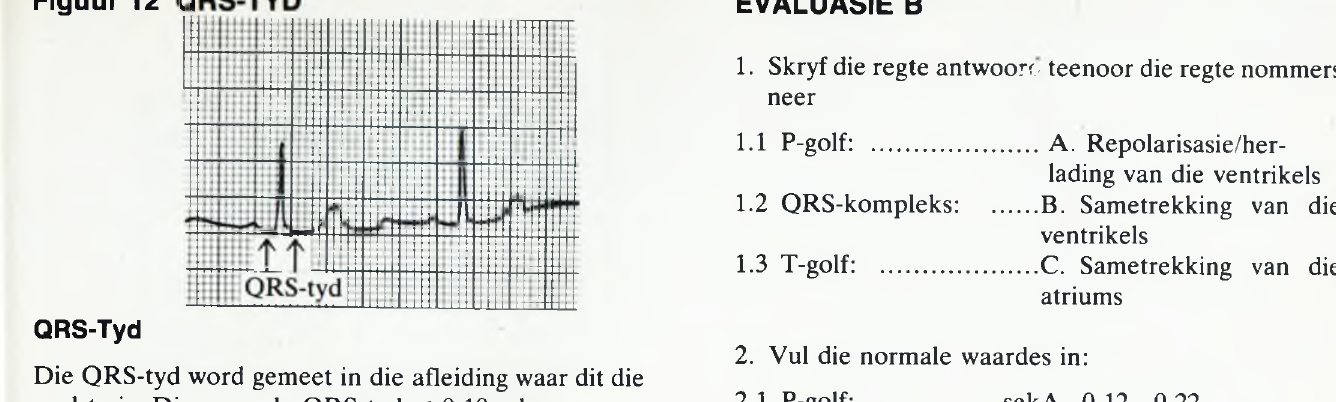
Figuur 13 Die T-Golf